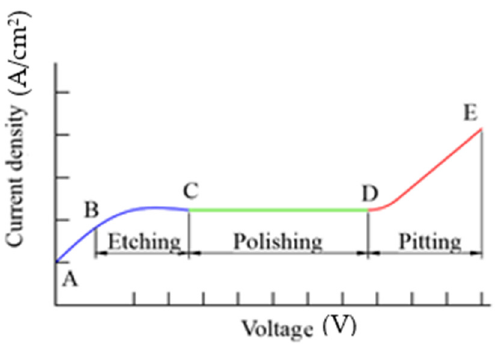
Figure 1. Redraw of a typical polarization curve [9]. The axis of ordinates is described in the logarithm of the current density (ASD) up to 1, and potential voltage is up to several volts for steel.